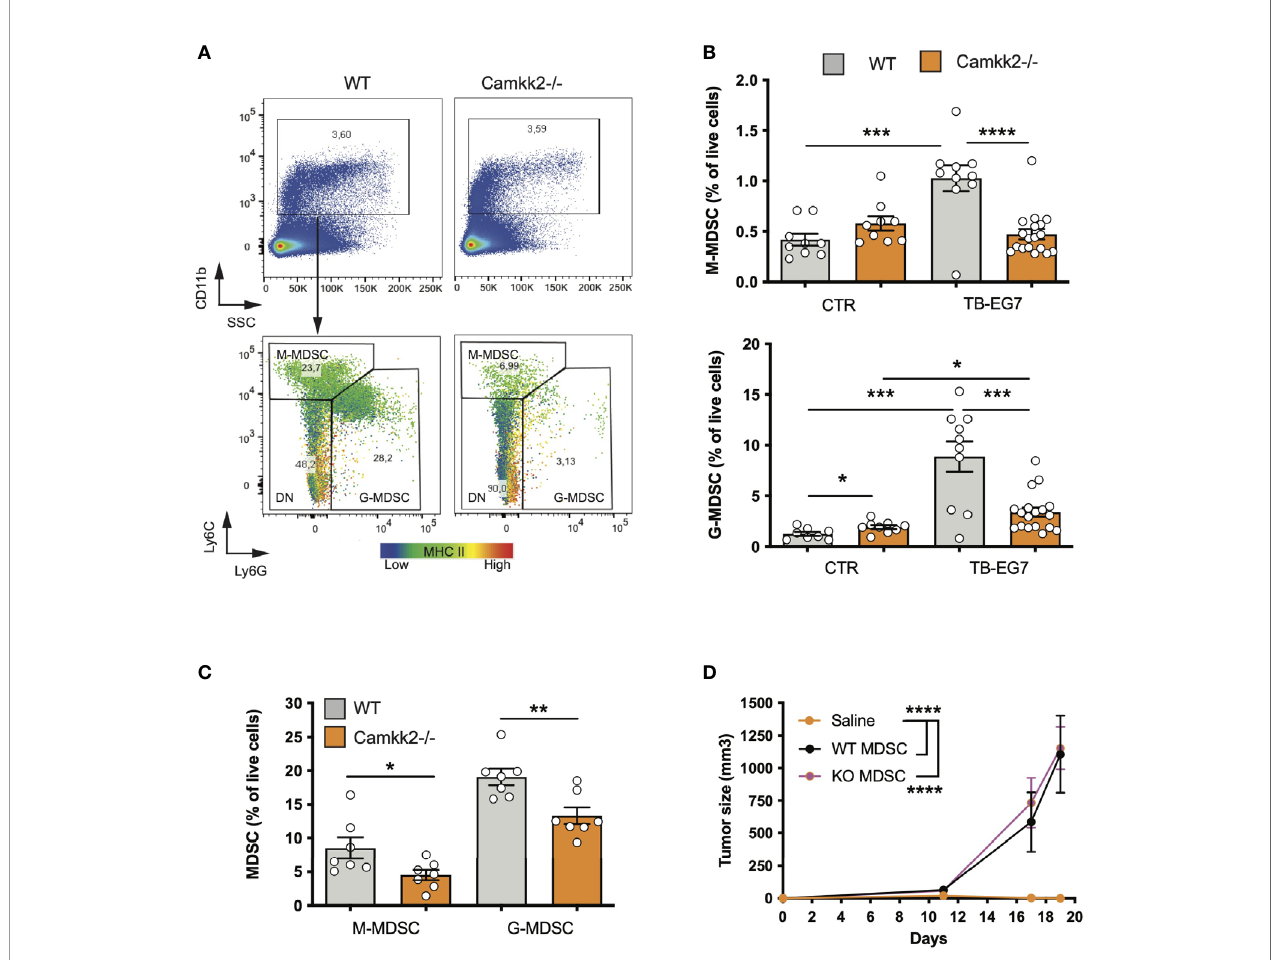
FIGURE 2 | Deletion of Camkk2 in the host prevents tumor-induced MDSC expansion. WT and Camkk2 -/- mice were injected with E.G7-OVA s.c. in the fl ank (1×10 5 cells/mouse). Spleens and tumors were removed, and single cell suspensions were stained for myeloid markers and analyzed by FACS. Groups of WT and Camkk2 -/- mice not injected with tumor cells were used as control. (A) Gating strategy and representative plots of splenocytes isolated from tumor-bearing WT and Camkk2 -/- mice 17-21 days after injection. The heatmap indicates MHC II intensity in B and Ly6C intensity in C, respectively. (B) Percentages of M-MDSC, G-MDSC subsets in the spleen of normal and tumor-bearing mice (CTR and TB-EG7, respectively). (C) MDSCs in tumors removed from WT and Camkk2 -/- mice. (D) 1×10 4 E.G7-OVA were injected s.c. in the fl ank of Camkk2 -/- mice. At the same time, mice were injected IV with Gr1+ MDSC isolated from the spleen of tumor-bearing WT or Camkk2 -/- mice. The vehicle group received an equal volume of saline only. N=5 mice/group. Repeated twice. *, **, *** and **** refer to p< 0.05, 0.01, 0.005, and 0.001